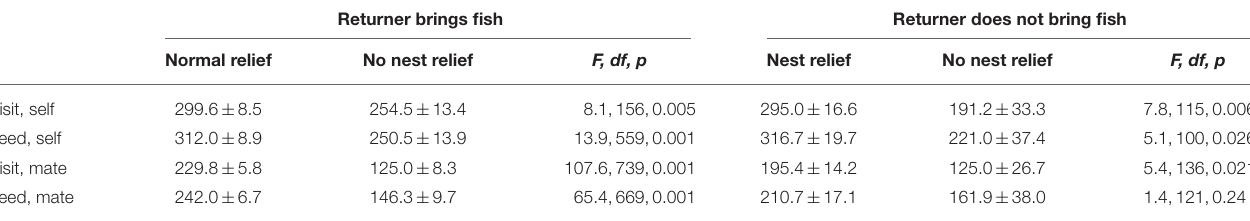
TABLE 4 | Mean ± se for time (min) between visits and feeds for focal birds (self) and their mates. Returner brings fish Returner does not bring fish Normal relief No nest relief F, df, p Nest relief No nest relief F, df, p